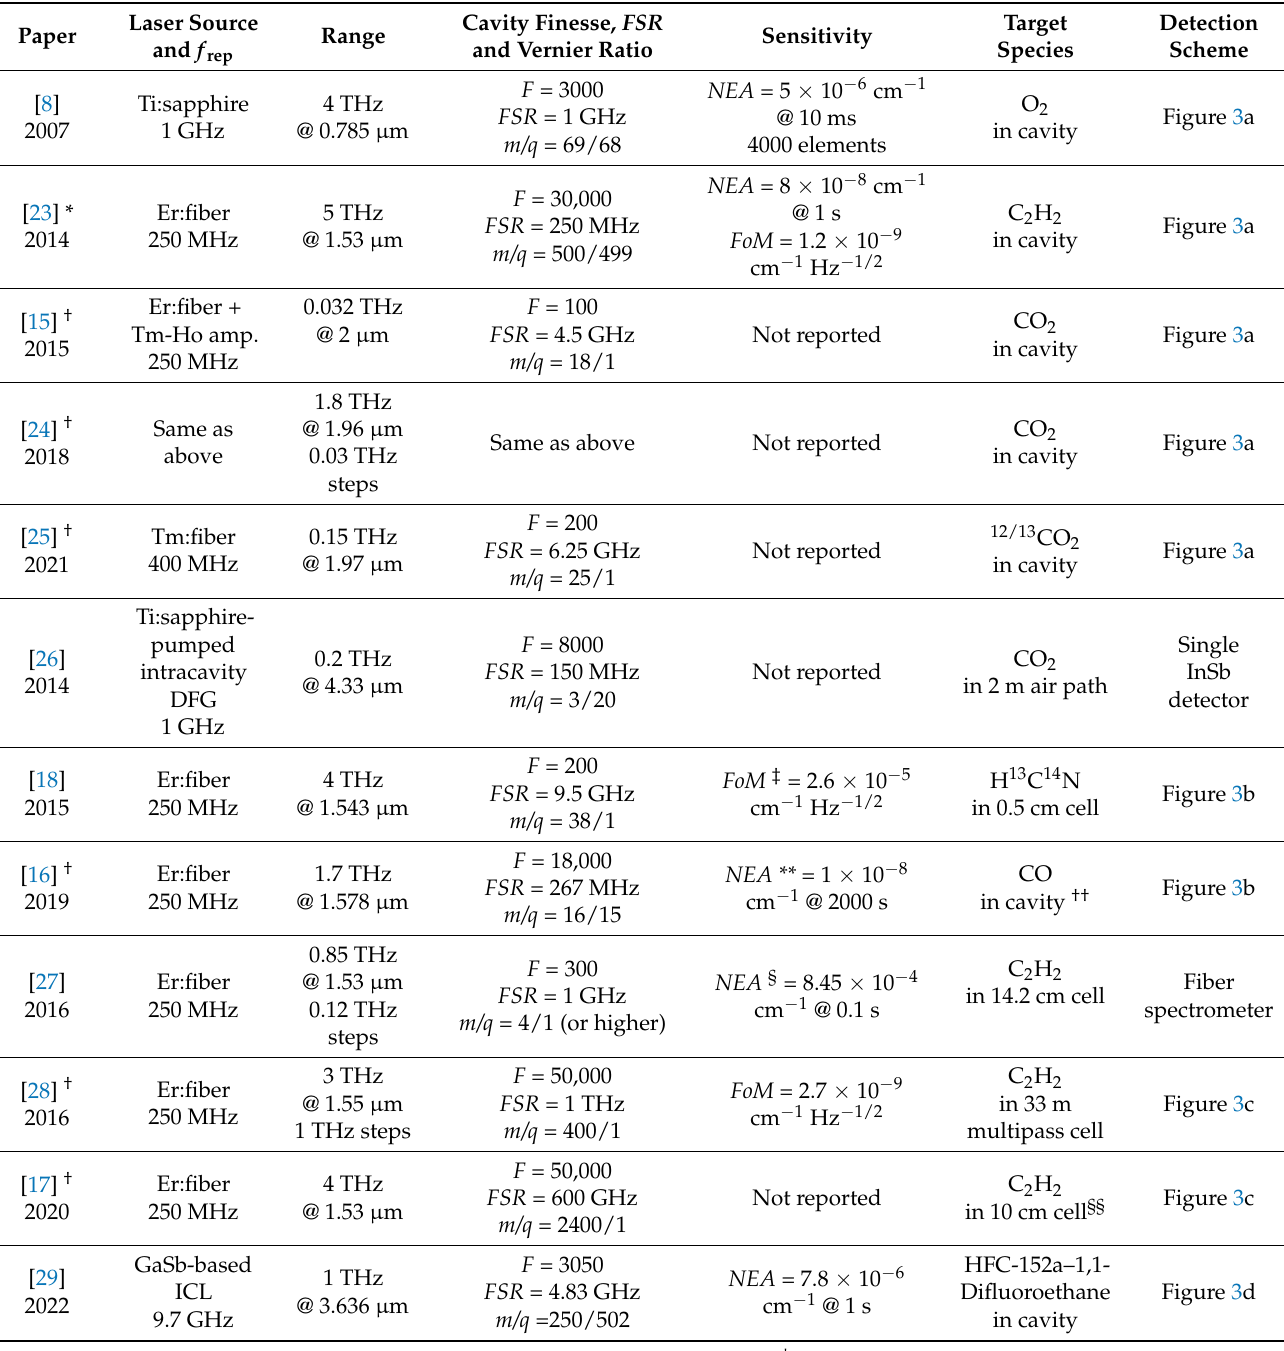
Table 1. Summary of comb-resolved Vernier spectroscopy demonstrations. See text for